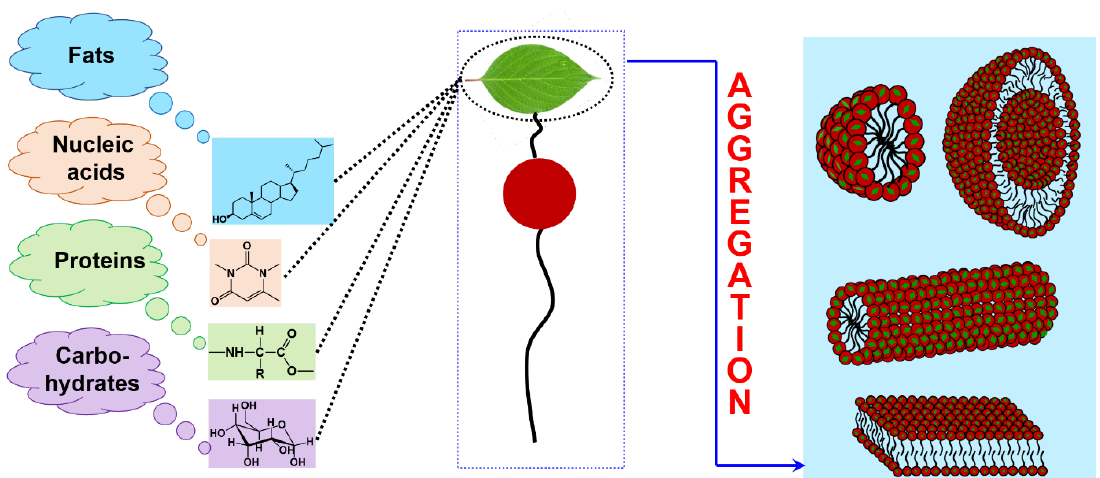
Figure 3. Schematic representation of nature-inspired amphiphiles and their possible various morphological structures.